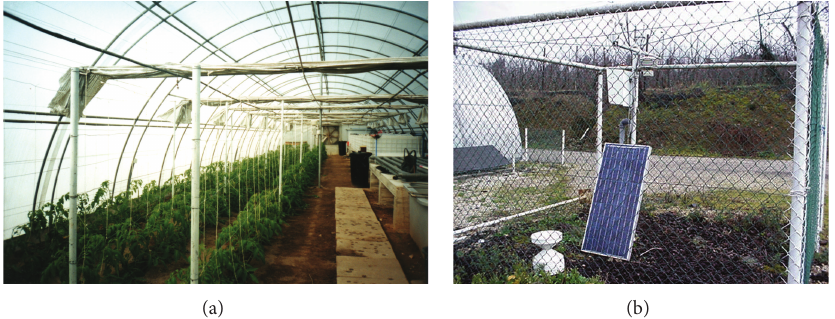
Figure 1: The experimental setup: a greenhouse with floor area of 210 m 2 (a). Indoor temperature, relative humidity, soil temperature, and CO 2 are measured. In the outside, wind speed, outside air temperature, relative humidity, and solar radiation are measured by a weather station located in the greenhouse vicinity (b).